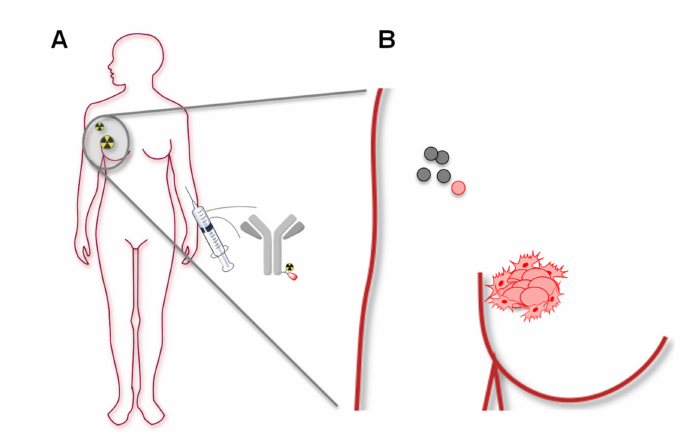
Figure 1. Schematic depiction of the operation principle of combined multimodal positron emission tomography / computed tomography (PET / CT) and near-infrared fluorescence optical imaging (NIR-OI) imaging. The first step is the injection of the multimodal, target-specific imaging agent and whole-body PET / CT imaging ( A ) followed by the intraoperative NIR-fluorescence optical image-guided surgery where the optically active compound clearly delineates e.g. tumor margins and identifies malignantly transformed lymph nodes ( B